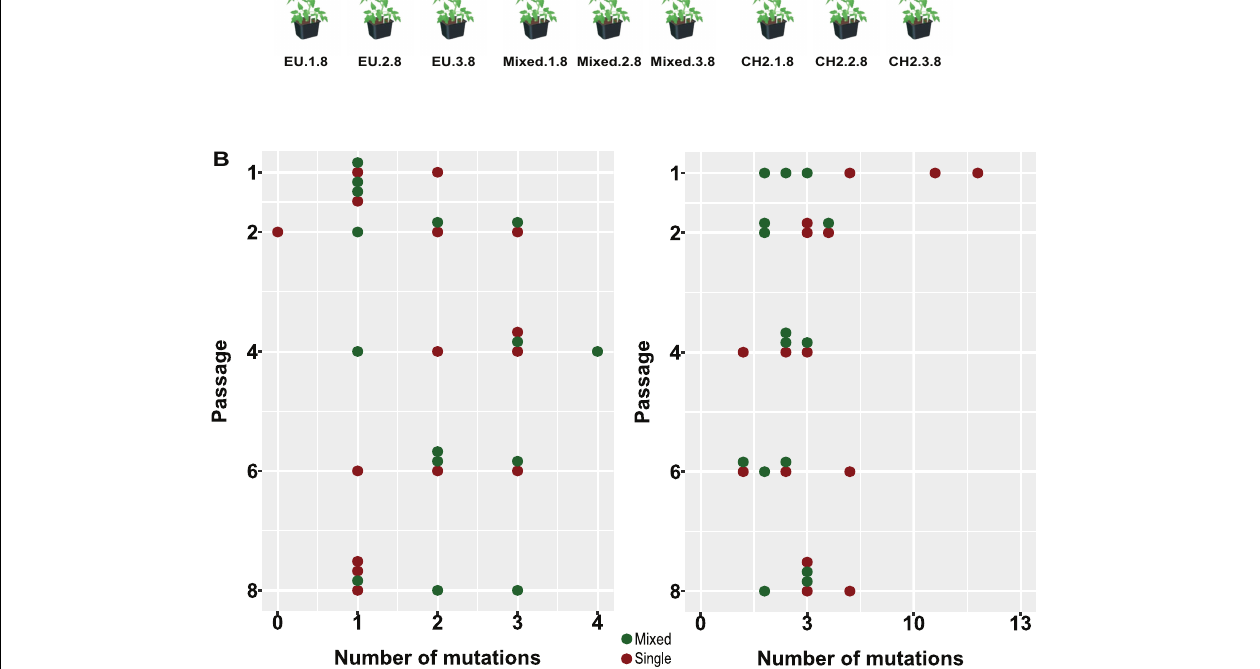
among viral strains, including super-infection exclusion and synergism. From a perspective of PepMV control through the use of cross-protection, our findings come as a warning, as